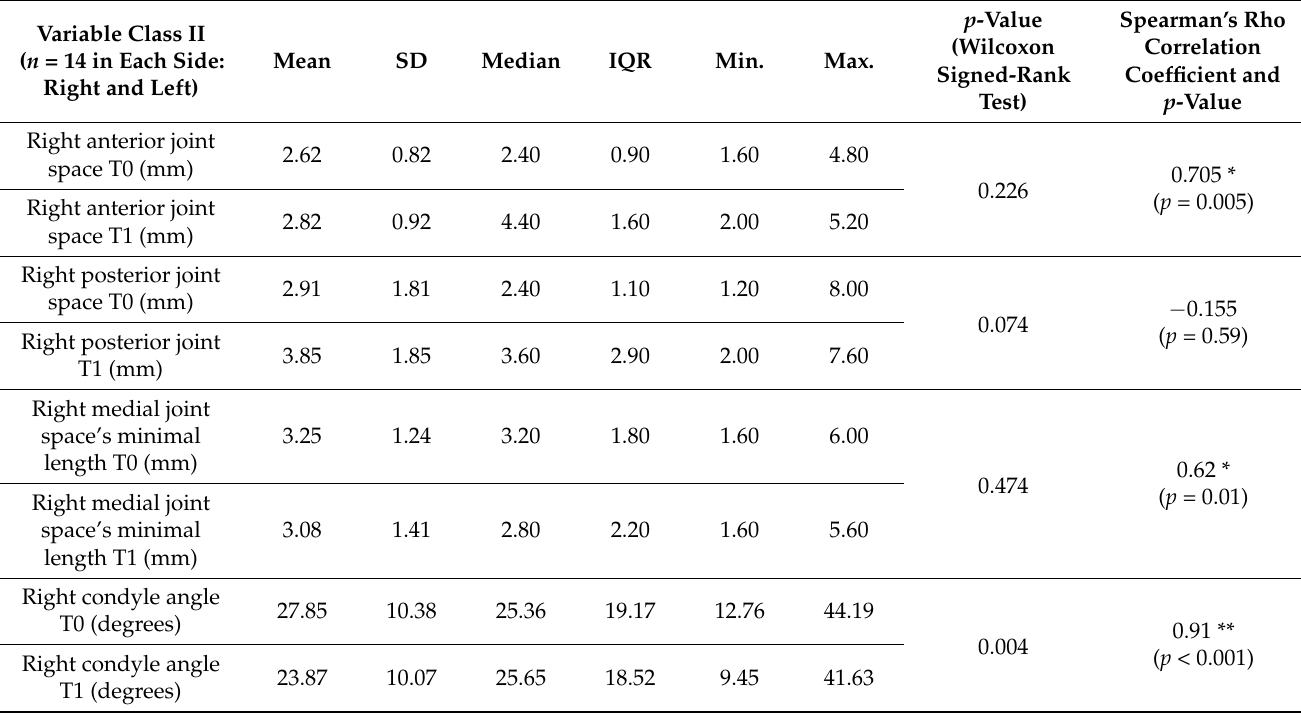
Table 4. The characteristics of the studied variables in class II and III, left and right